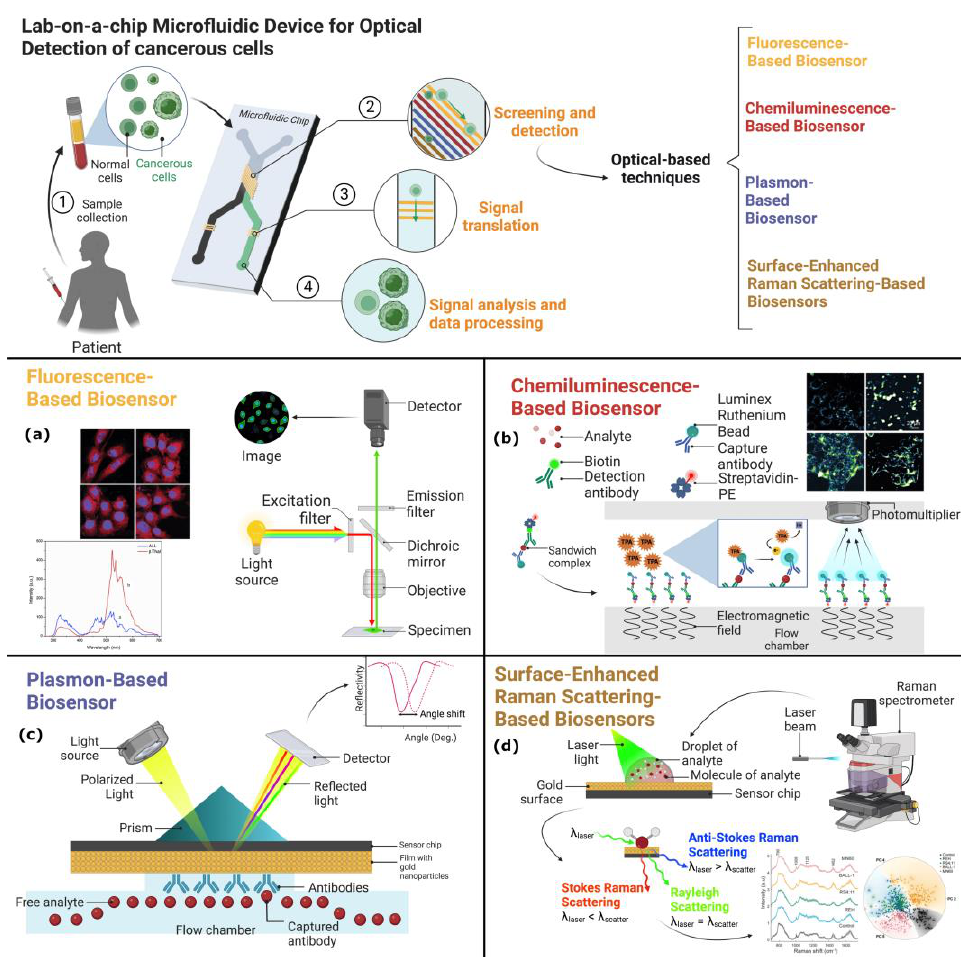
Figure 1. The schematic diagram displays lab-on-a-chip microfluidic devices utilizing optical-based detection techniques. At the top, a standard microfluidic channel is shown, where a human sample containing normal and cancerous cells has been introduced. The cells pass through microchannels, and a screening and detection step is performed using an optical-based detection technique. The four types of sensor chips depicted are ( a ) fluorescence-based biosensor, ( b ) chemiluminescence-based biosensor, ( c ) localized surface plasmon resonance, and ( d ) surface-enhanced Raman scattering sensor chips. Insets of micrographs adapted with permission from Refs. [20,21] a and b, respectively and [22] for d. Copyright 2019 WILEY and 2019 and 2021 Elsevier. (Created with Biorender.com).